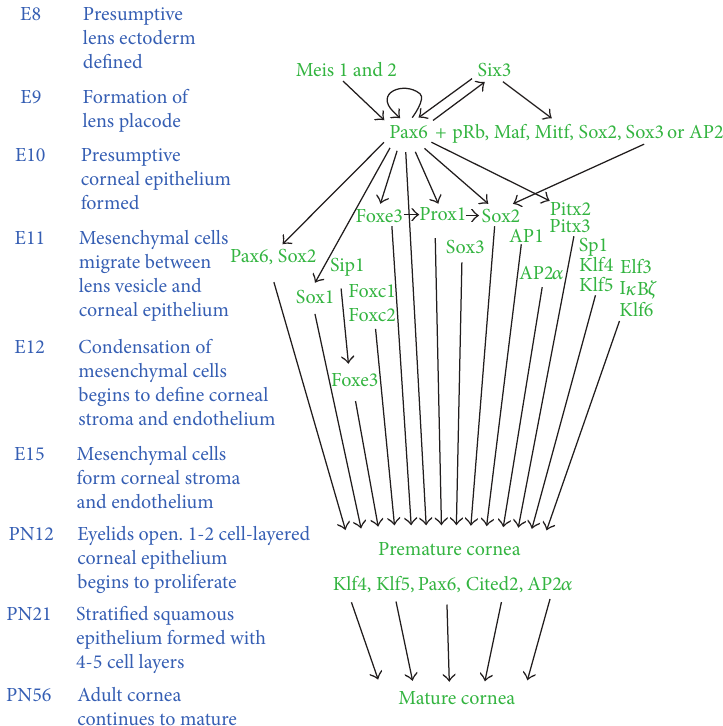
Figure 4: Transcription factors affecting corneal development. Pax6 serves as a master regulator of eye development in association with a handfulofothertranscriptionfactors.Whiletheinvolvementofseveraltranscriptionfactorshasbeenstudiedinearlyembryonicdevelopment of the eye, few studies have focused on postnatal maturation of the cornea. Embryonic (E) or postnatal (PN) developmental stages (in days) are shown on the